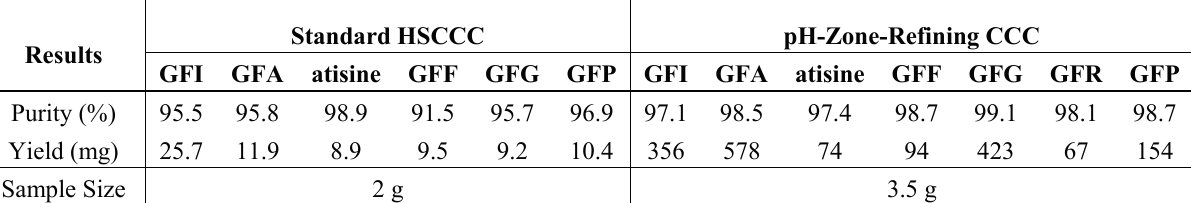
Table 2. The compartion of two separation